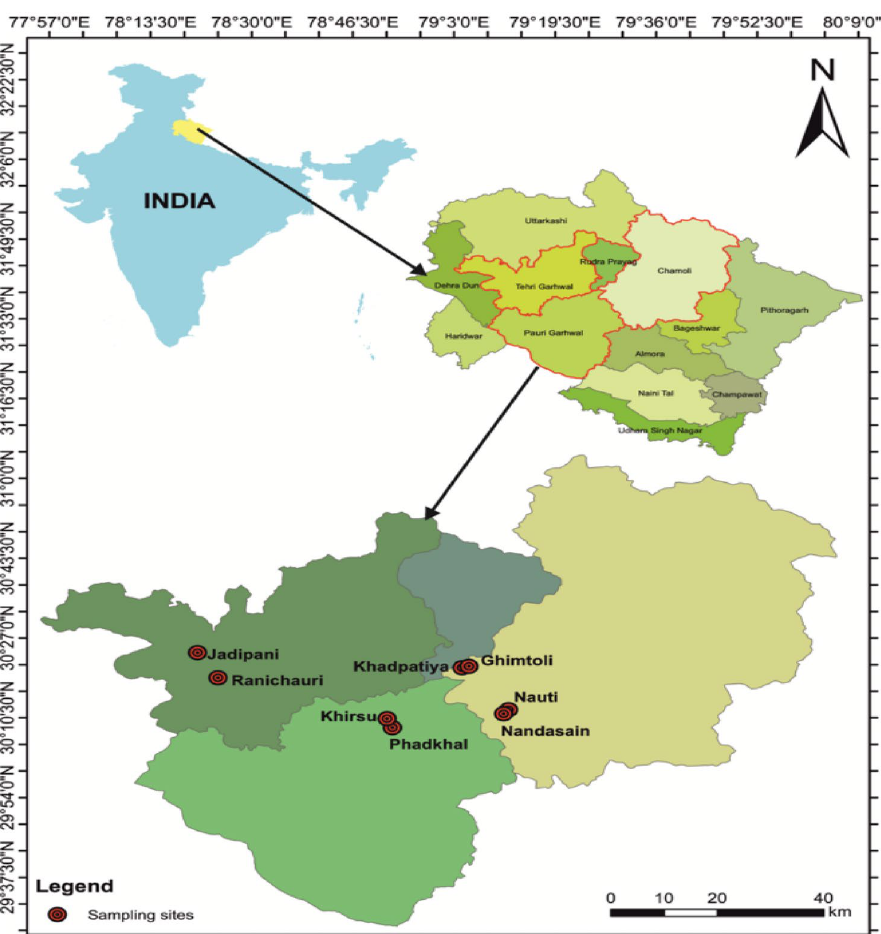
Figure 1. Locations of Rhododendron arboreum study sites in Garhwal region (ARC GIS software 10.5 version was used for map preparation. The map was created by Mr. Raman Patel, Research scholar, Dept. of